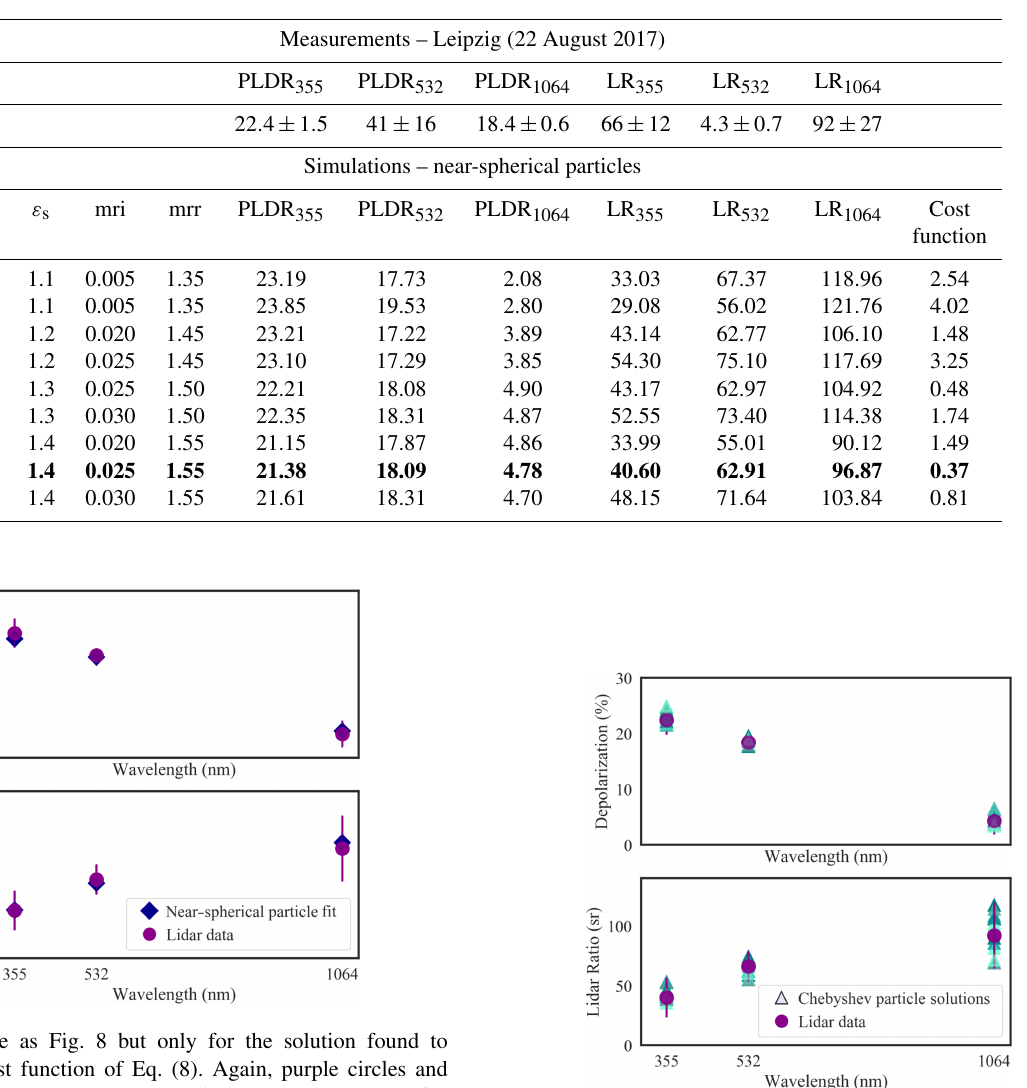
Table 3. Calculated properties of near-spherical particles that reproduce the PLDR and LR at 355, 532 and 1064nm, as reported in Haarig et al. (2017). Also shown is the corresponding cost function of each solution. The solution that minimizes the cost function (Eq. 8) is highlighted in bold.